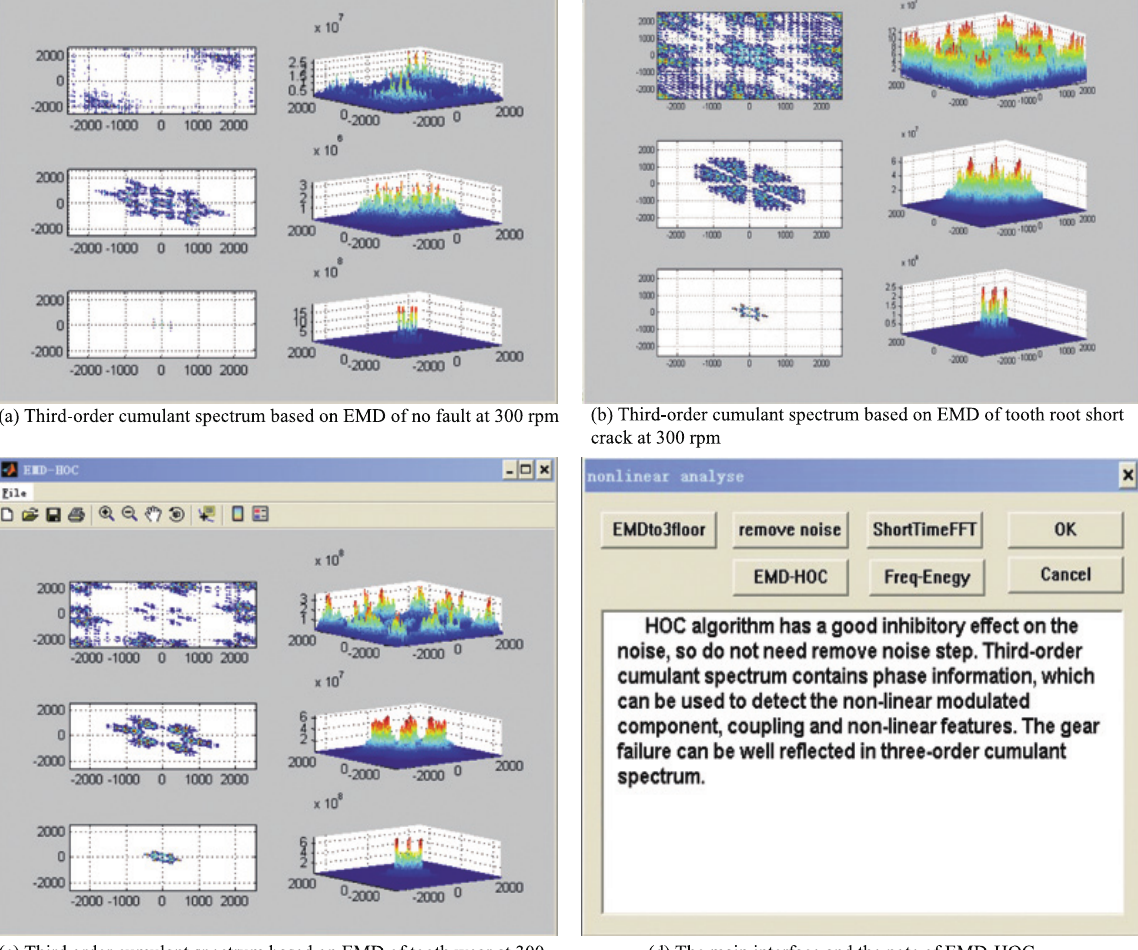
Fig. 16. The analysis interface of